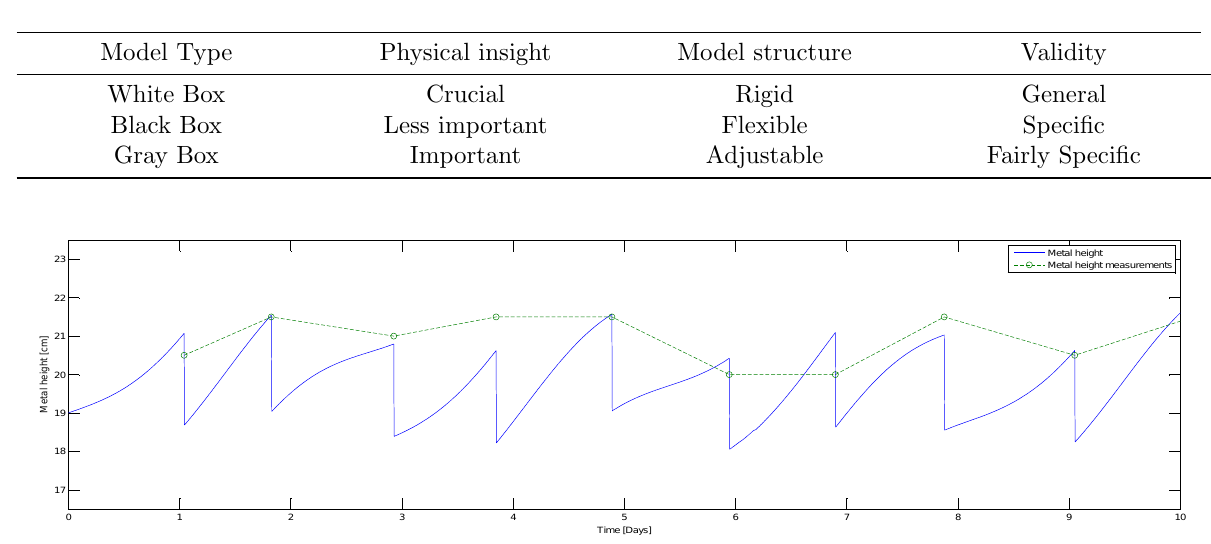
Figure 4: Synthetic data set showing metal height steadily increasing with sudden drops in its values, due to tapping, over a period of time, in this case about 10 days. It is common to measure the metal height just before the metal tapping, once a